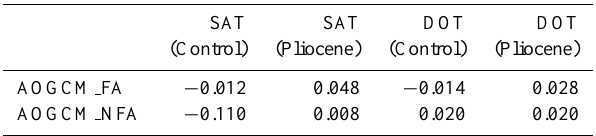
Table 5. Trends of global annual mean values ( ◦ C 100yr − 1 ) during the last 100yr in individual integrations. SAT